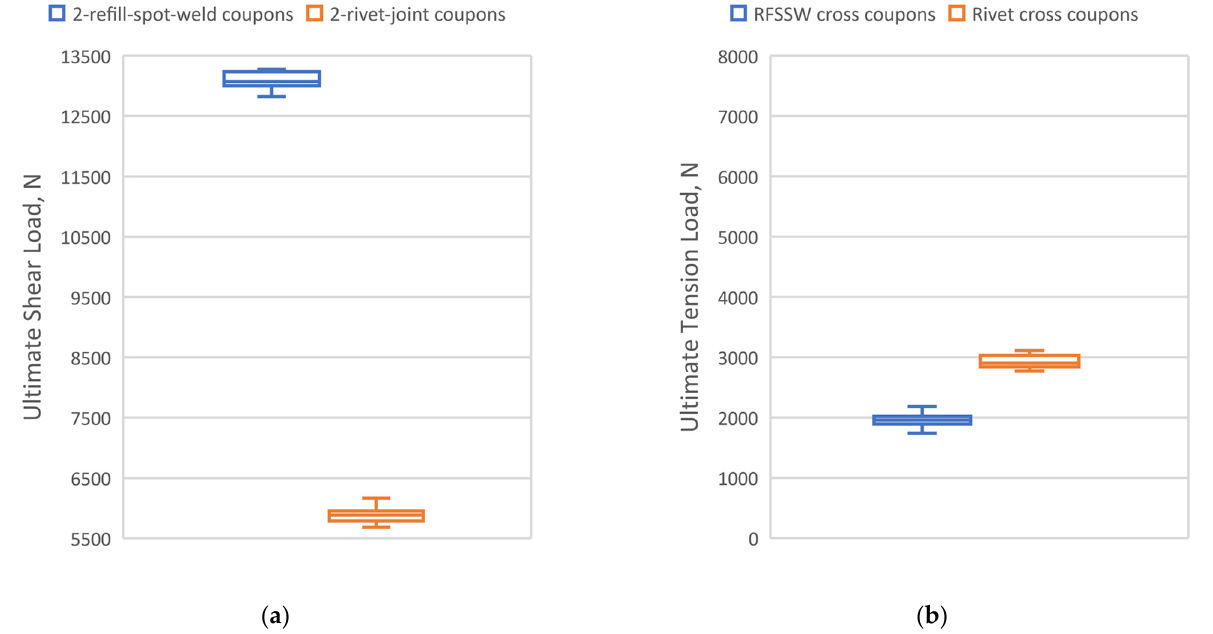
Figure 8. Box-whisker plots of static load test results: ( a ) ultimate shear loads of 2-spot coupons and ( b ) ultimate tension loads of cross coupons. The 2-spot coupons were tested in accordance with NASM-1312-4, and the cross coupons were tested in accordance with ISO-14272.